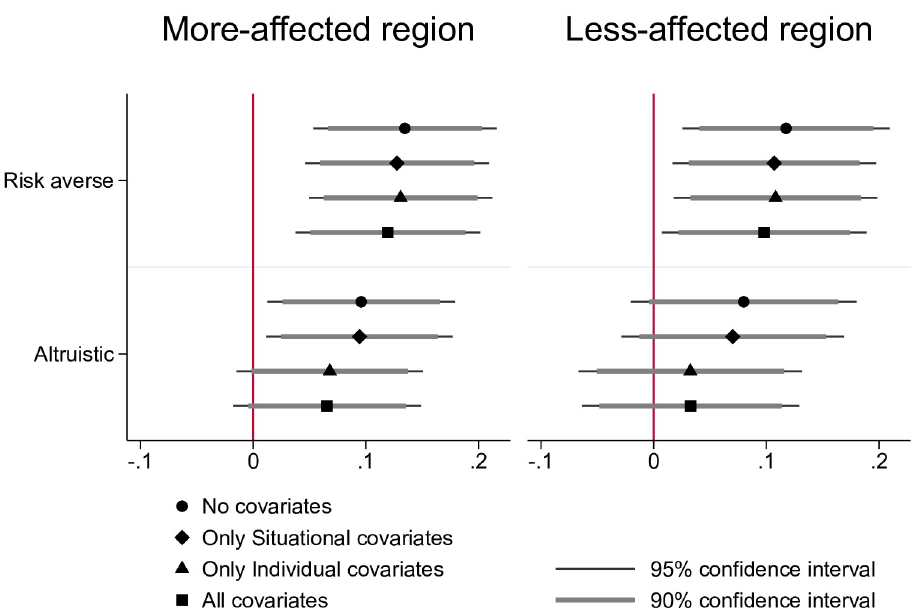
Fig 3. Motivations behind mask wearing. In this figure, we visualize the results from regressing mask wearing on the variables of interest risk aversion and altruism. The x-axis shows the estimate for the coefficient on risk aversion and the estimate for the coefficient on altruism first without covariates, then including only situational covariates, then including only individual covariates, and finally including both. The thin line represents the 95% confidence interval and the thick line represents the 90% confidence interval. Risk aversion and altruism are binary variables standardized at median. Situational covariates include having had COVID-19 symptoms, household size, using public transport, having had contact to a COVID-19 infected person at work, having had contact to a COVID-19 infected person outside work, belonging to a COVID-19 risk group, living with a household member who belongs to a COVID-19 risk group, having traveled internationally for at least 2 days since 1st of February 2020. Individual covariates include being a health worker (doctor or nurse), age group, education group (low, medium or high level of education), being native and